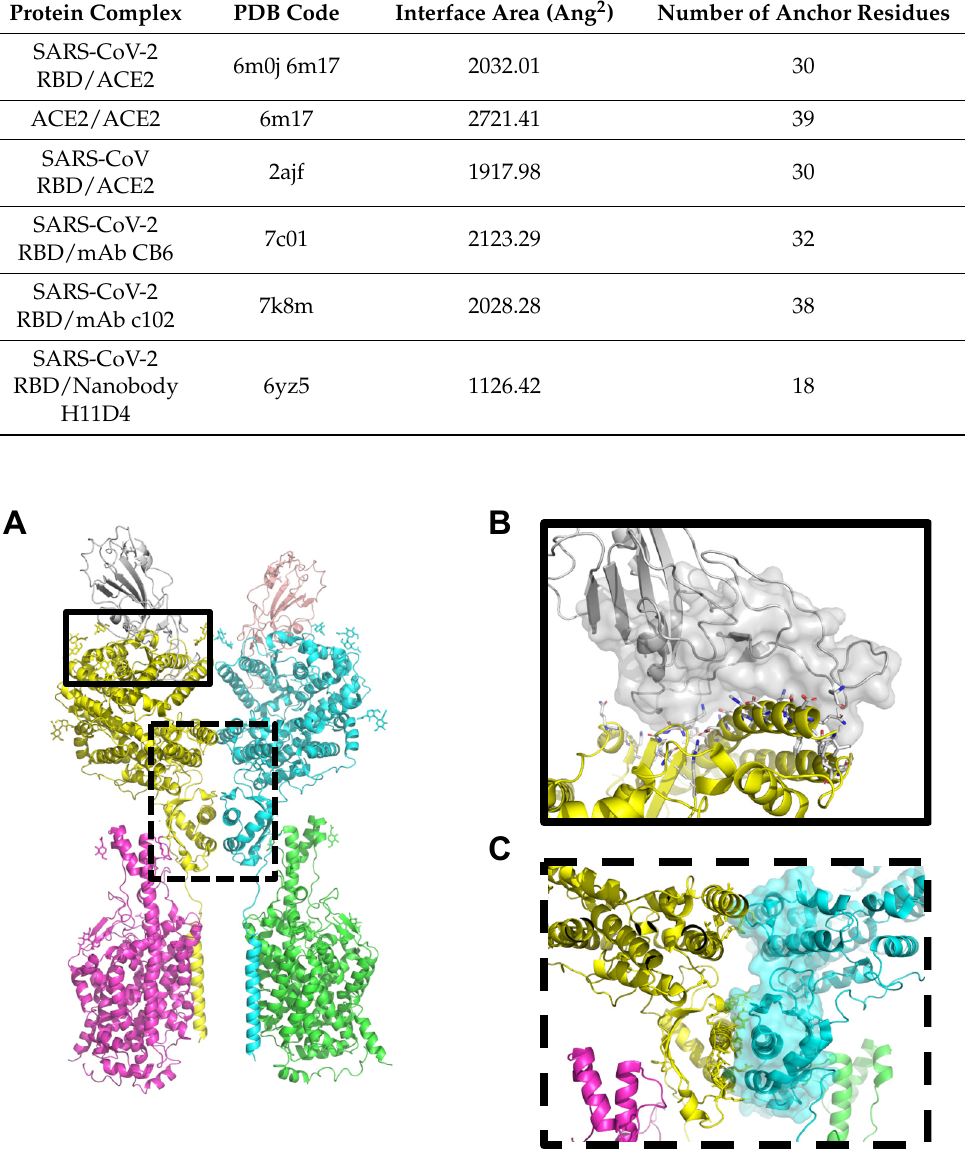
Figure 1. Interfaces targeted by designed peptides in the case of SARS-CoV-2 RBD and full length ACE2. ( A ) Cartoon representation of full length human ACE2 (yellow, cyan)/BoAT1 (magenta, green) and RBD (grey, pale pink). ( B , C ) Interface targeted by peptides where ( B ) shown and enlarged view of the interface between ACE2 (yellow, cartoon) and RBD (grey, surface) and ( C ) and enlarged view of the interface between ACE2 monomers (yellow and cyan).